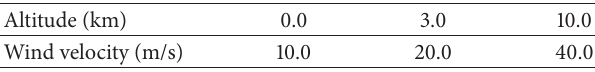
Table 4: Wind velocity in different altitudes.